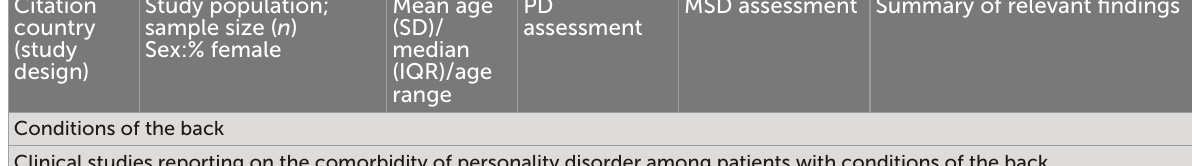
TABLE 1 Summary of relevant findings on the comorbidity between PD and MSDs, according to MSD category, study population, and